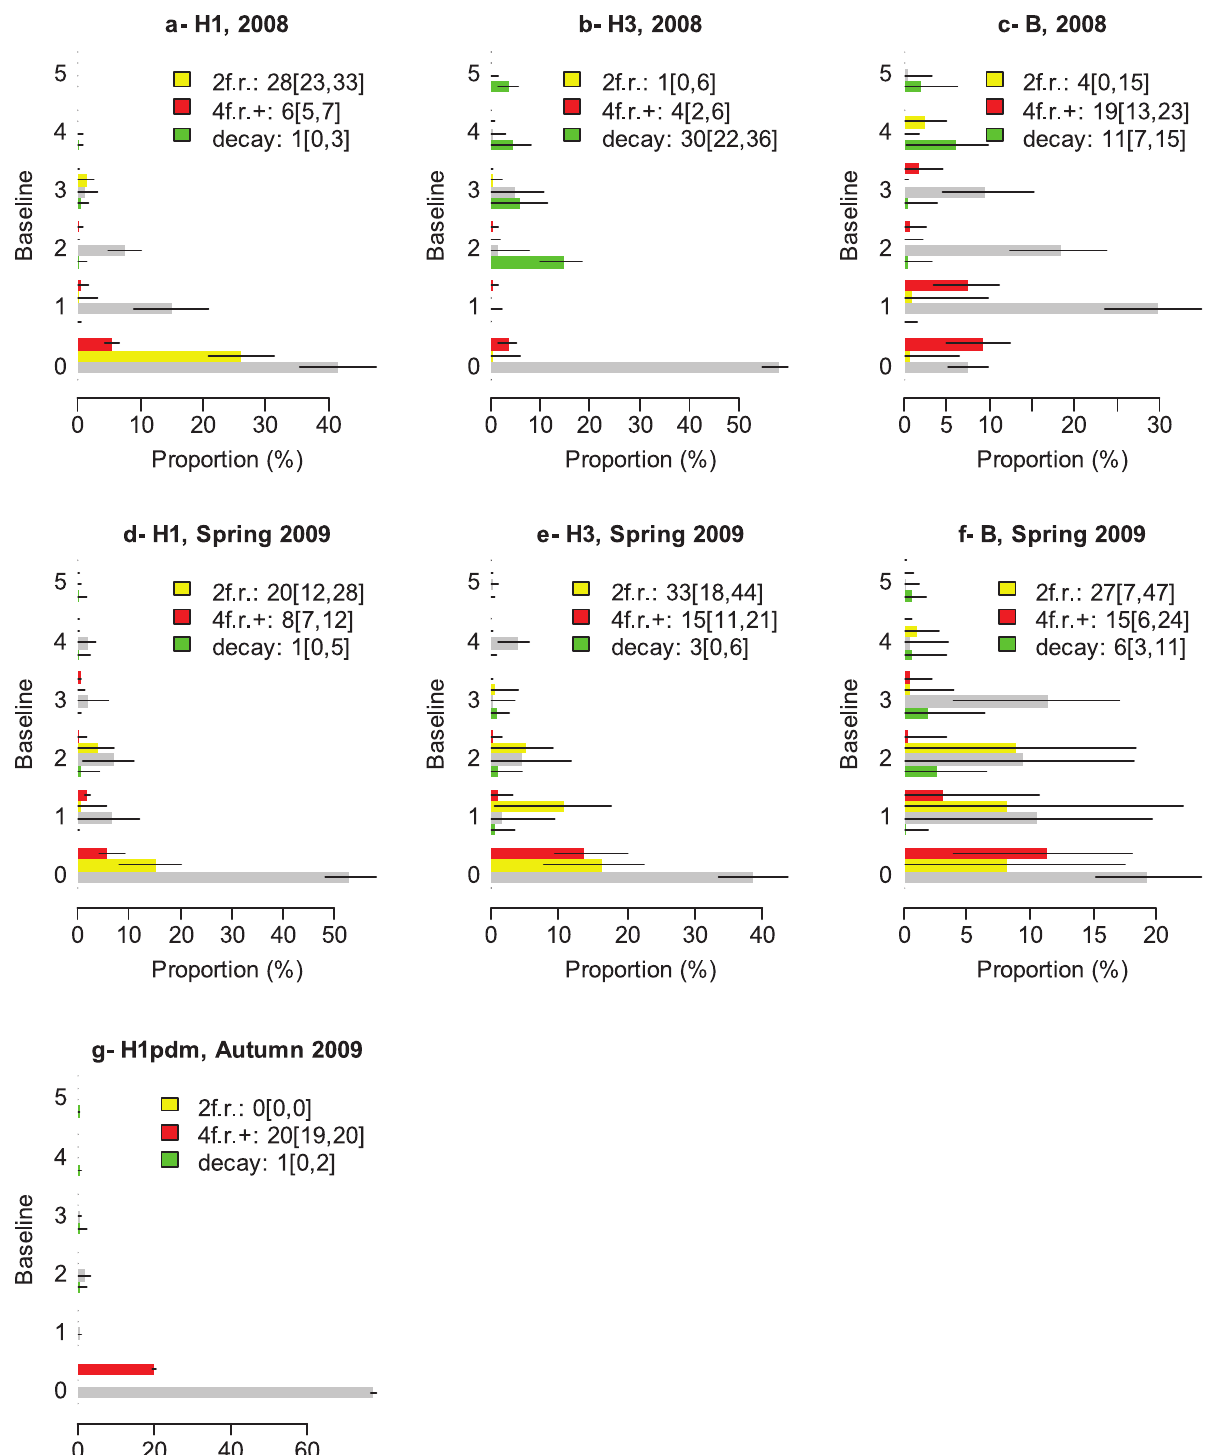
Figure 2. Distribution of paired serology, corrected for measurement errors as a function of season (2008, Spring 2009, Autumn 2009) and subtype (H1N1, H3N2 and B) (in Autumn 2009, subtyping was only conducted for H1N1pdm09). In each panel, individuals are sorted by baseline AT levels on the y-axis. For a given baseline, the grey bar indicates the expected proportion of individuals with post AT level equal to baseline AT level; the yellow bar indicates the proportion with a 2 fold rise (2f.r.); the red bar indicates the proportion with a 4 fold rise or more (4f.r. + ); the green bar indicates the proportion with a decay. The black thin lines give the 95% CI. The legend gives the mean [95% CI]. A : H1N1, 2008. B : H3N2, 2008. C : B, 2008. D : H1N1, Spring 2009. E : H3N2, Spring 2009. F : B, Spring 2009. G : H1N1pdm09, Autumn 2009.